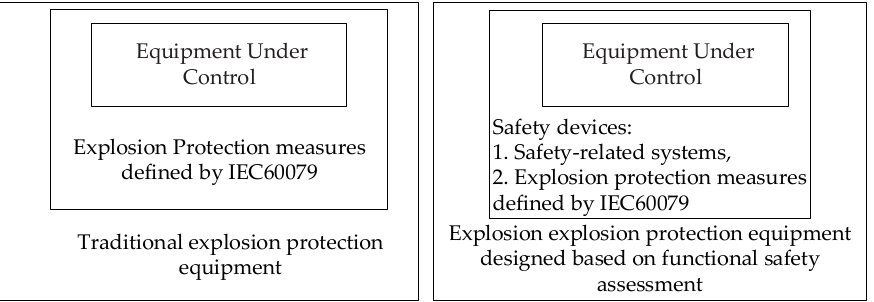
Figure 1. Outline of explosion protection equipment based on functional safety assessment.